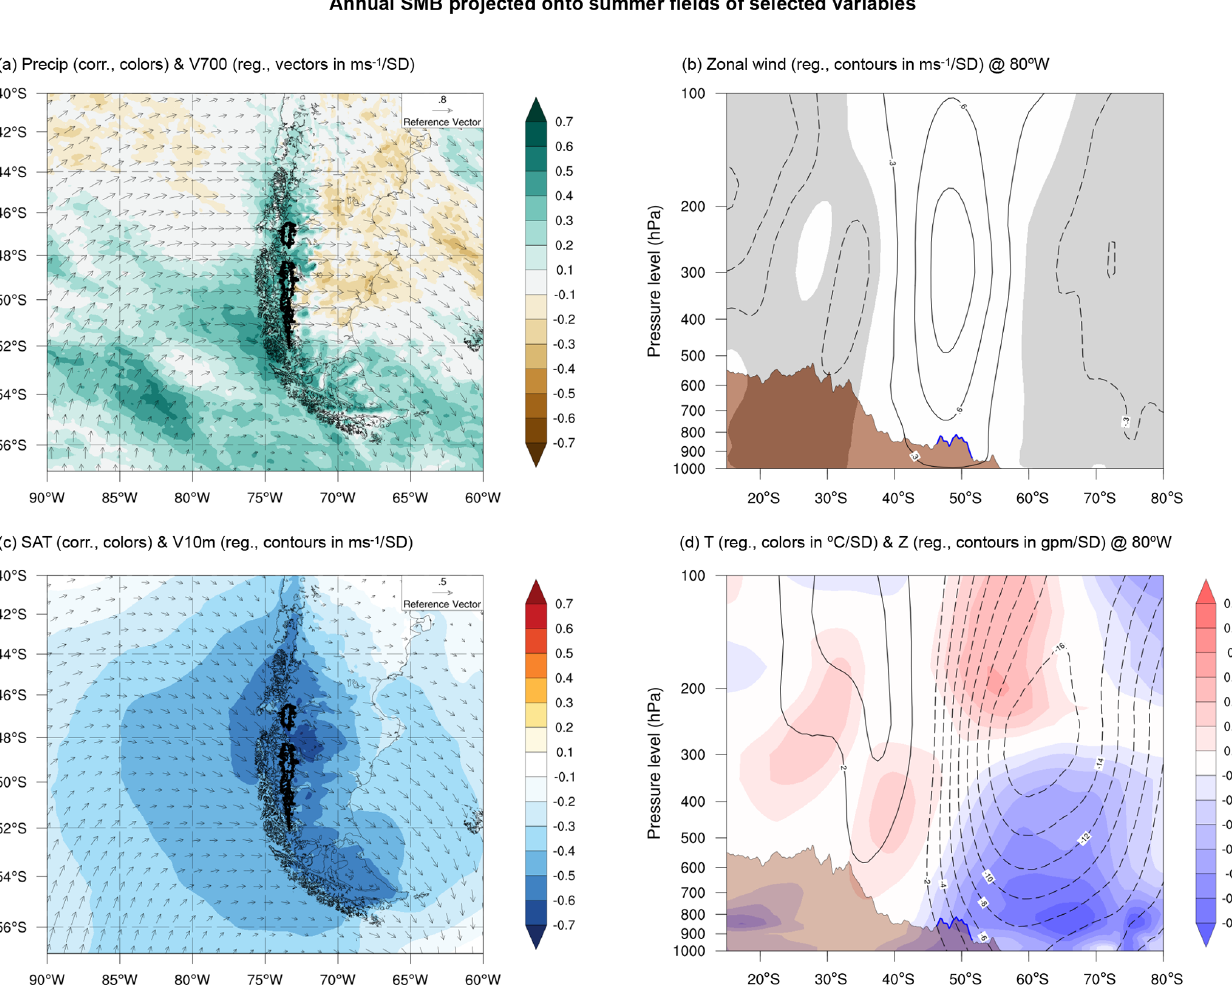
Figure 7. The same as in Fig. 5 but for the summer (October to